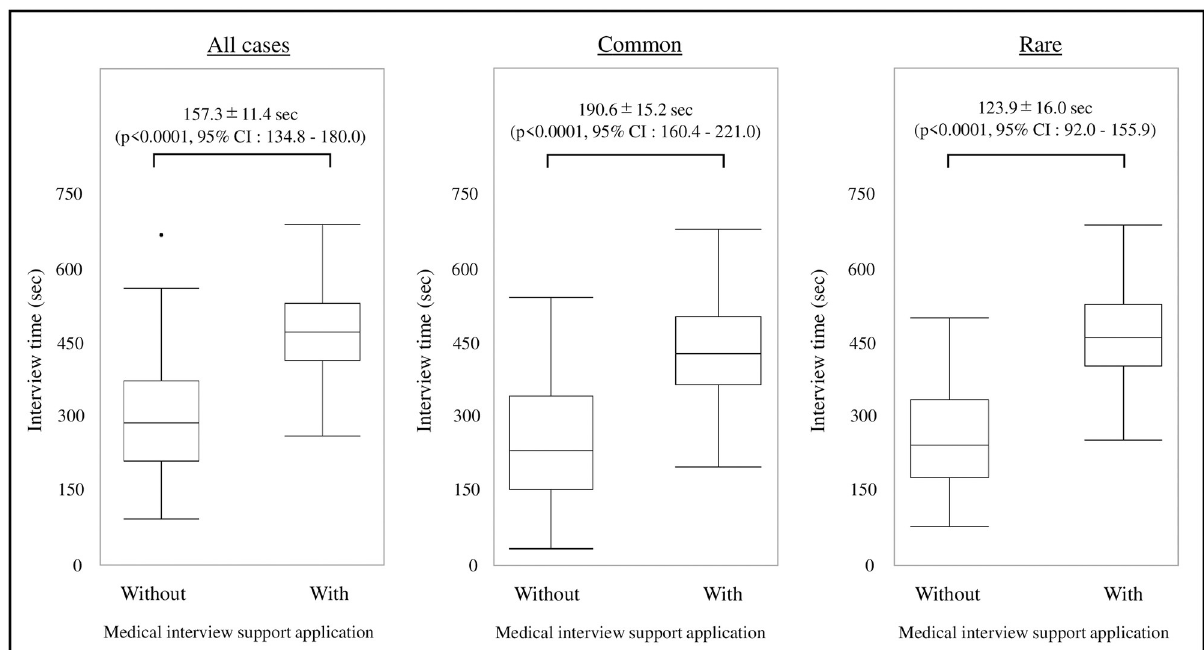
Fig 3. Duration of the medical interview. A box-and-whisker diagram of the interview time for the groups with and without the medical interview support application is shown. In all validations, the interview time was significantly longer for the group that used the medical interview support